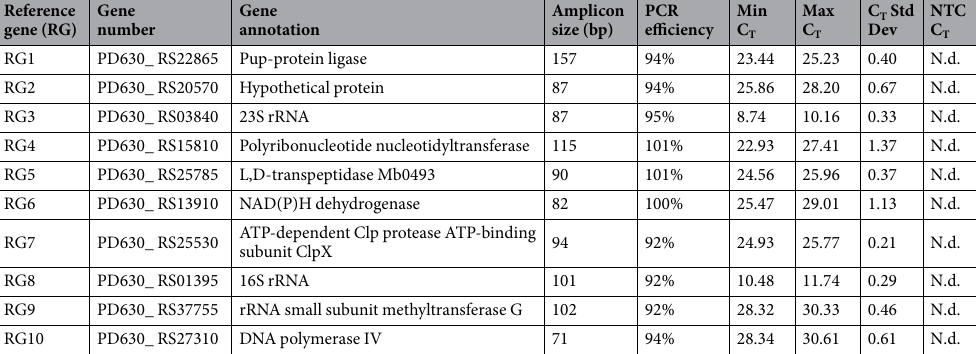
Table 1. List of candidate reference genes (RGs). The amplicon size, PCR efficiency percentage, minimum and maximum threshold cycle (C T ) values observed across all tested growth conditions, the standard deviation of C T values across all tested growth conditions (determined by BestKeeper), and the C T value of the no template control (NTC) are listed for each RG. See Supplementary Figure 1 for standard curves used to calculate PCR efficiency. See Supplementary Figure 2 for melting curve analysis. See Supplementary Table 1 for oligonucleotide sequences and melting and annealing temperatures. N.d. = no amplification